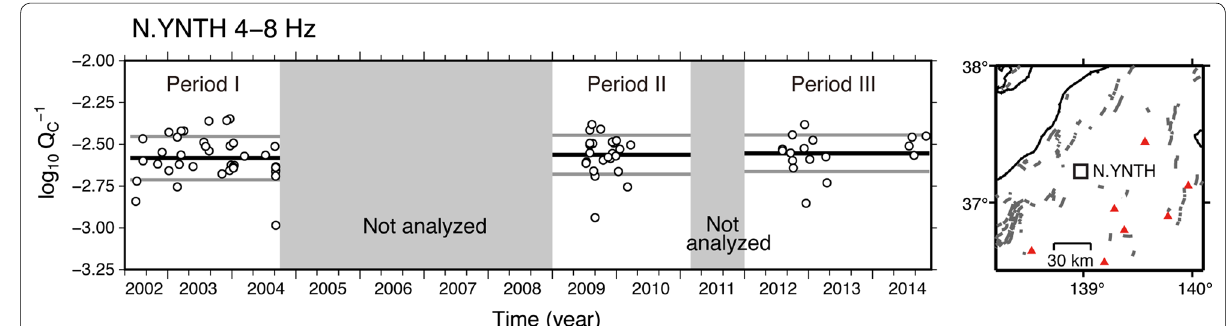
Fig. 4 Left panel: temporal variation in coda Q − 1 at the station N.YNTH. Black lines show the mean of log 10 Q C − 1 , and gray lines show a range of standard deviation of the mean in each period. The data in the Period III are taken from Dojo and Hiramatsu (2017). Right panel: the location of the station